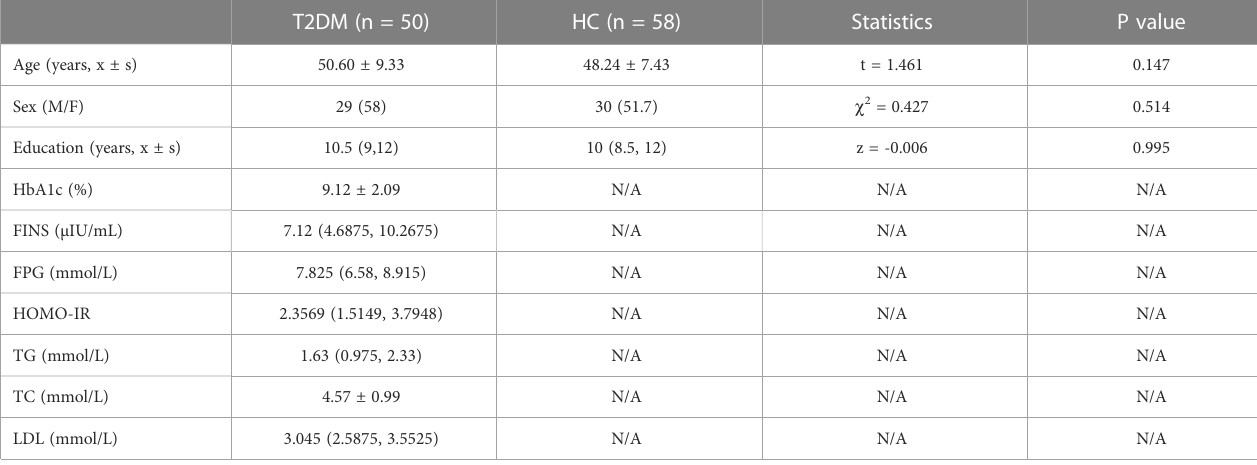
TABLE 1 Demographic data and clinical biochemical indicators of all